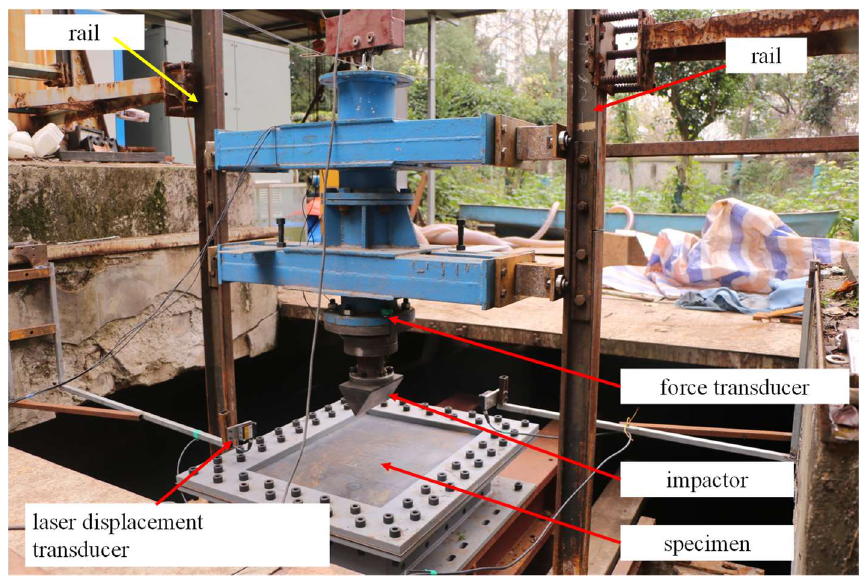
Figure 1. Drop-weight impact test tower.